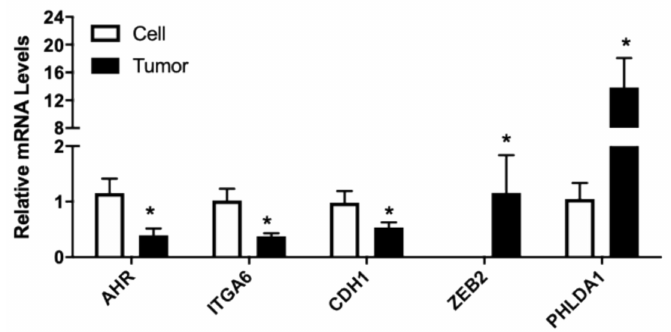
Figure 3. Relative mRNA levels of selected genes in cultured LNCaP cells and LNCaP xenograft tumors. RNA was isolated from culture LNCaP cell and LNCaP tumor xenograft and gene expression determined using real-time RT-PCR, as described in Materials and Methods. Results were normalized to the cultured cell control and expressed as relative mRNA levels (mean ± SD, n = 15 for cells and 18 for tumor samples); p -values ≤ 0.05 were considered as significant and * indicates significantly different from control.